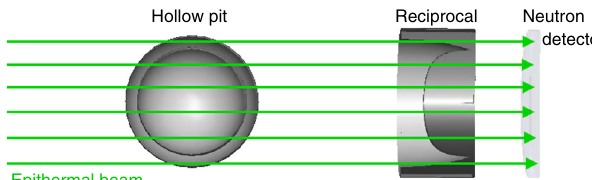
Fig. 2 A diagram of the pit and its reciprocal mask in a radiographic con fi guration. The combined transmission image will be identical to that of a fl at plate with a thickness equal to the external thickness of the